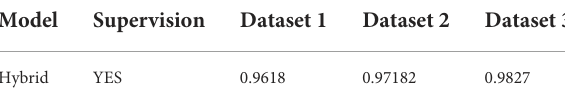
TABLE 6 Analysis of word on